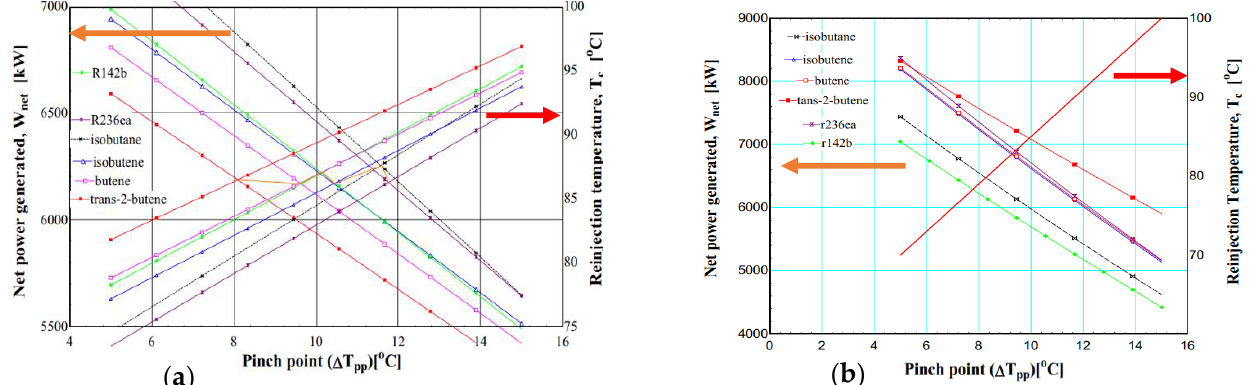
Figure 7. Effects of pinch point on the net power output and reinjection temperature for the working fluids investigated. A pinch point of 8 ◦ C has reinjection temperatures above 80 ◦ C for simple orc ( a ). An increase in pinch point decreases the heat transfer in the heat exchangers, thus reducing the flow rate of the working fluid. The net power output is directly proportional to the mass flow rate of the working fluid. ( b ) The effect of varying reinjection temperature for the case of regenerative cycle between 70 and 100 ◦